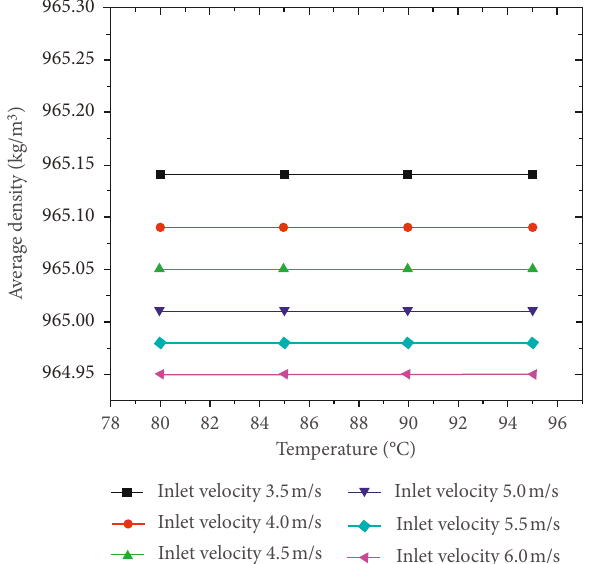
Figure 37: Temperature and average density with inlet velocity for 20% opening.